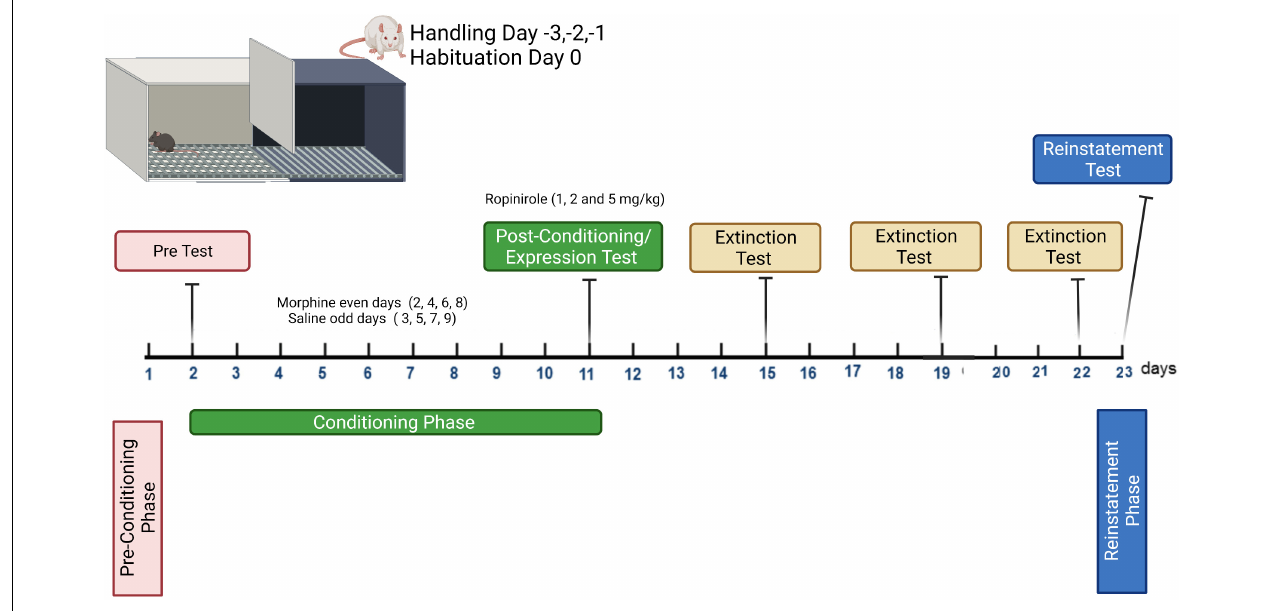
FIGURE 1 | Conditioning plan of the expression, extinction, and reinstatement program for morphine-induced conditioned place preference study.